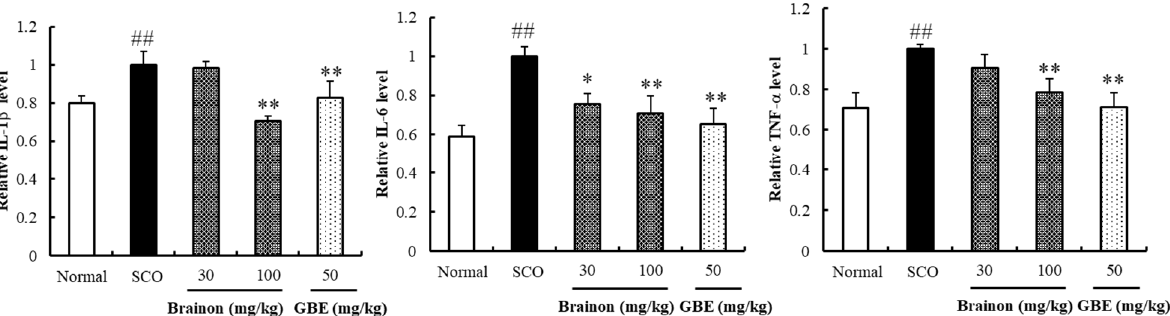
Figure 7. Effects of Brainon on anti-inflammation related mRNA expression in the memory deficit mice hippocampal tissues. Interleukin (IL)-1 β , IL-6, and tumor factor necrosis (TNF)- α was evaluated by real-time qPCR. The levels of IL-1 β , IL-6, and TNF- α mRNA were normalized utilizing the glyceraldehyde 3-phosphate dehydrogenase (GAPDH) as control. Values are represented as means ± SEM ( n = 3). ## p < 0.01 vs. Normal group; * p < 0.05 and ** p < 0.01 vs. SCO-treated group.